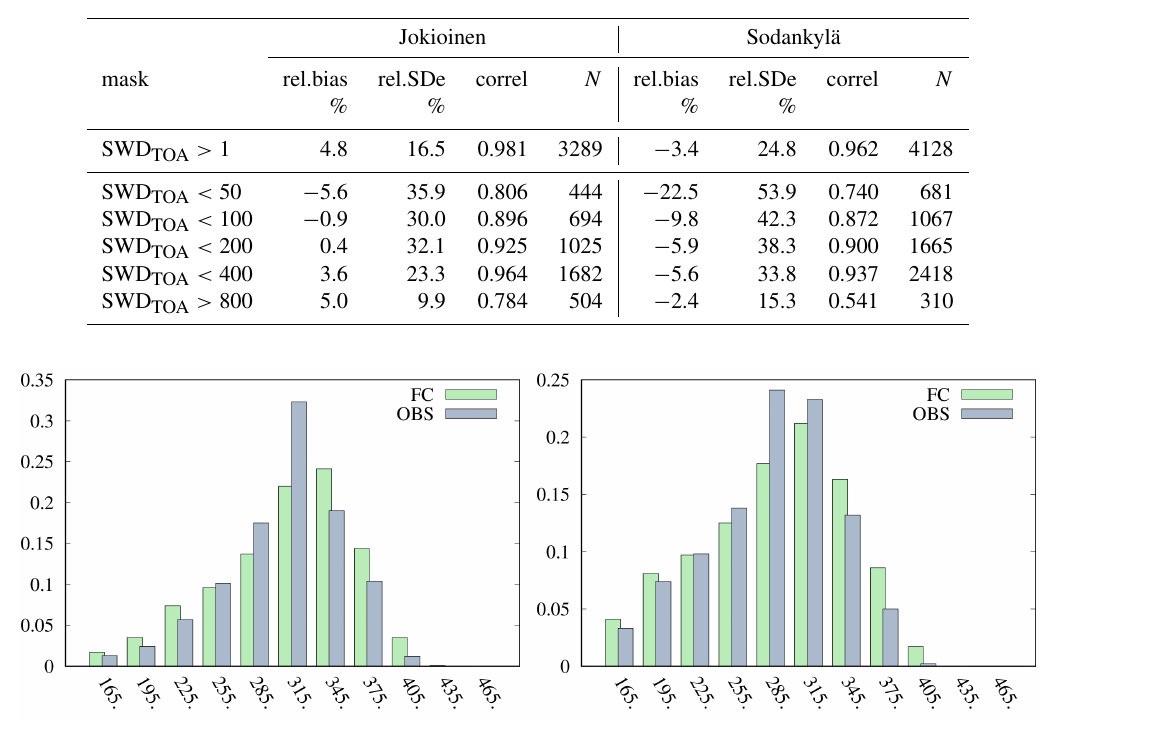
Table 4. HIRLAM forecast versus observed clear sky SWDS at Jokioinen and Sodankylä classified according to SWD TOA (unit Wm − 2 ) for